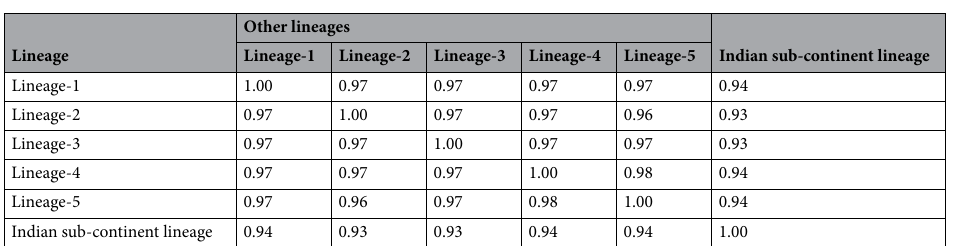
Table 2. E gene nucleotide similarity matrix between different lineages of the cosmopolitan genotype.